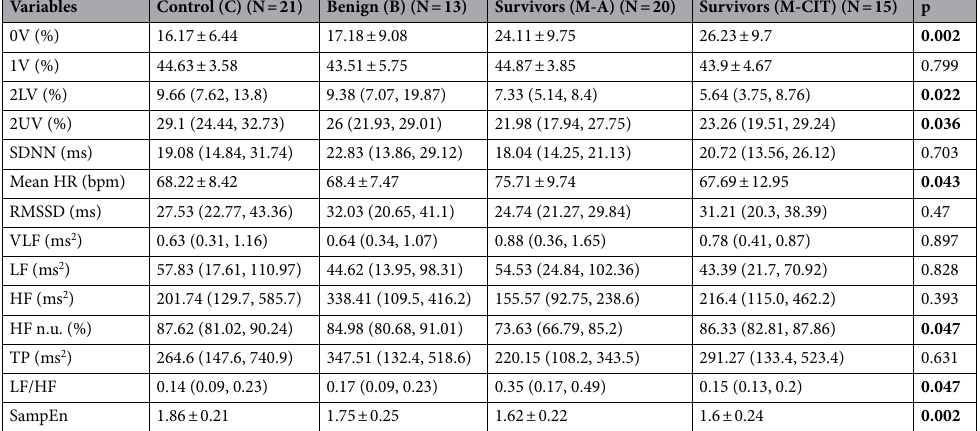
Table. 3. Comparison of HRV selected parameters among studied groups. Values are expressed as mean (SD) with normal distribution or median (Q1, Q3) without normal distribution. Bold values of p indicate statistical significance (value of p < 0.05). M-A survivors wit active cancer; M-CIT survivors after completed initial treatment, 0V zero variation, 1V one variation, 2LV two like variations, 2UV two unlike variations, interval differences, SampEn sample entropy, SDNN standard deviation of all normal-to-normal intervals, TP total power, VLF very low frequency.